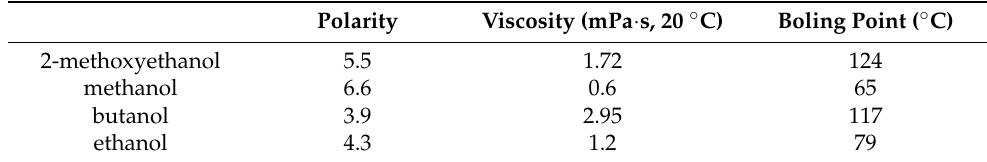
Figure 4. AFM characterizations of ZnO NPs on the blue QDs film with the solvent of ( a ) 2-Methoxyethanol, ( b ) methanol, ( c ) butanol, and ( d ) ethanol. For each sample, the pseudo-three-dimensional image, the height image, and the line-scan profile are shown from left to right. Table 2. Summarized properties of different solvents.